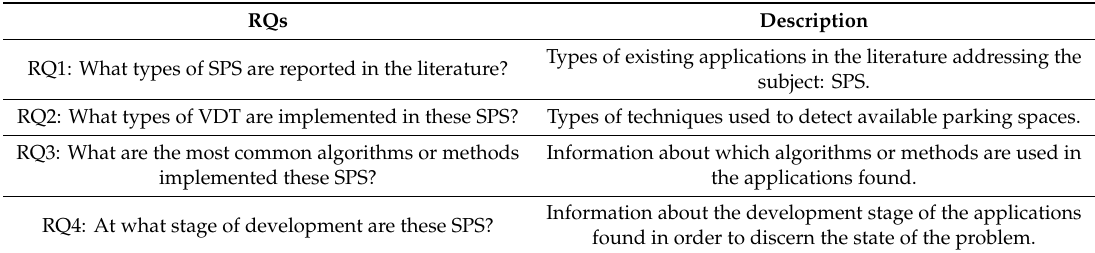
Table 2. Research questions